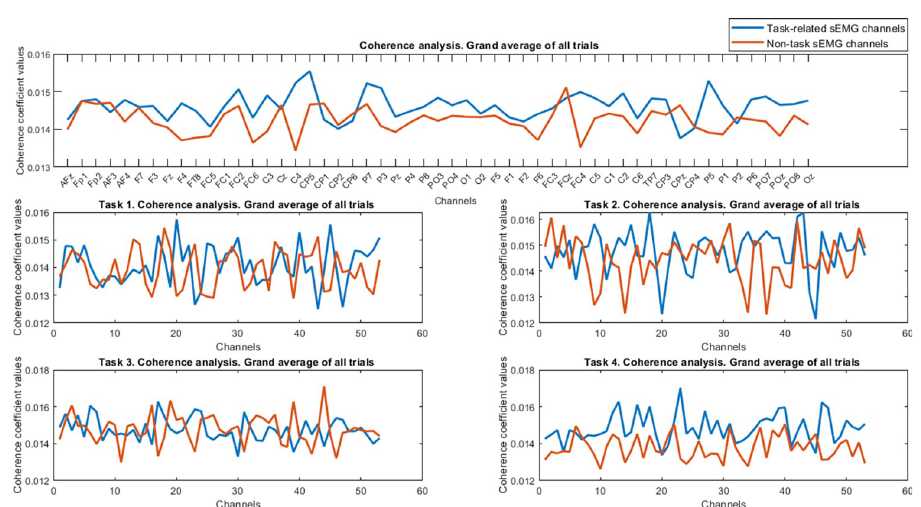
Fig 4. Results of coherence analysis for whole trials are depicted. Generally, we couldn’t judge whether stronger coupling values existed or not for the task-related sEMG channels compared to the non-task channels in row 1. In rows 2 and 3, the grand average results of total coherence for each task are presented. Almost higher coupling values for tasks 2 and 4, but for task 1 and task 3, the values did not follow a consistent pattern along channels and we can see higher values only for specific channels in task-related sEMG channels. The legend for all subplots is the same as row 1.